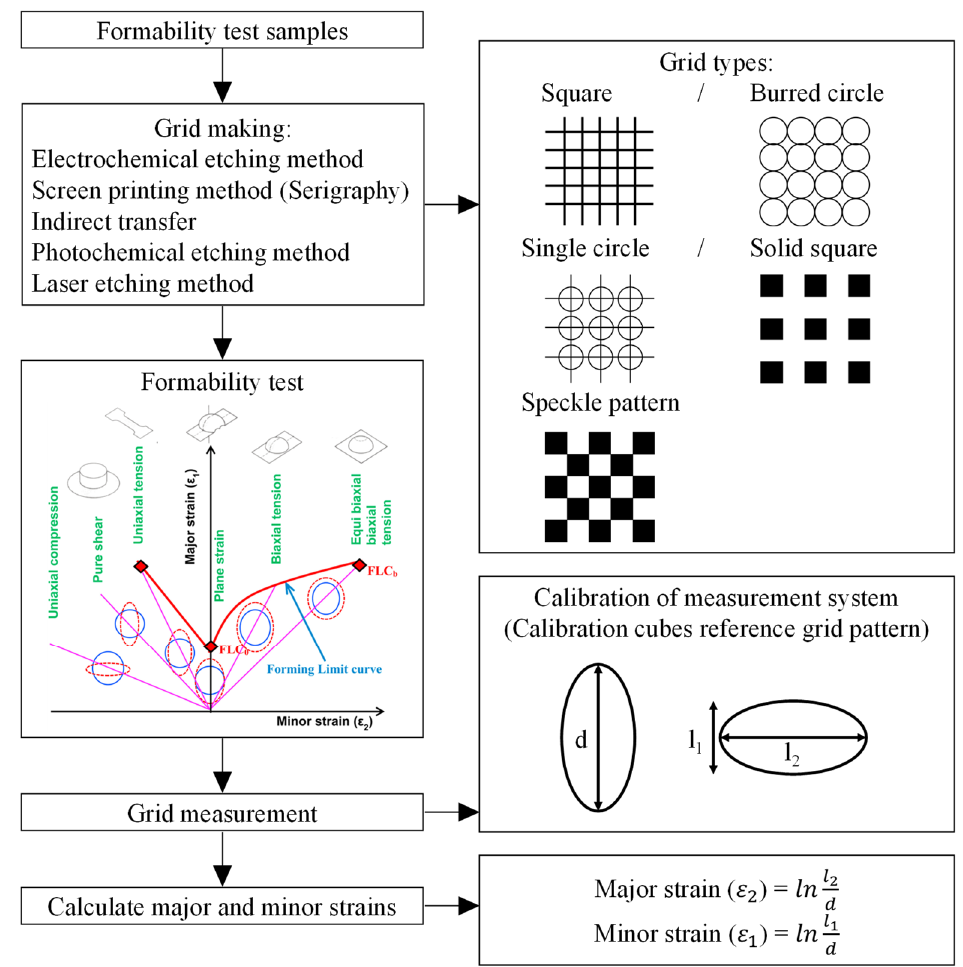
Figure 30. Detailed procedures of measuring major and minor strains manually. Reprinted from Ref. [325] with permission. Copyright 2016, Elsevier.